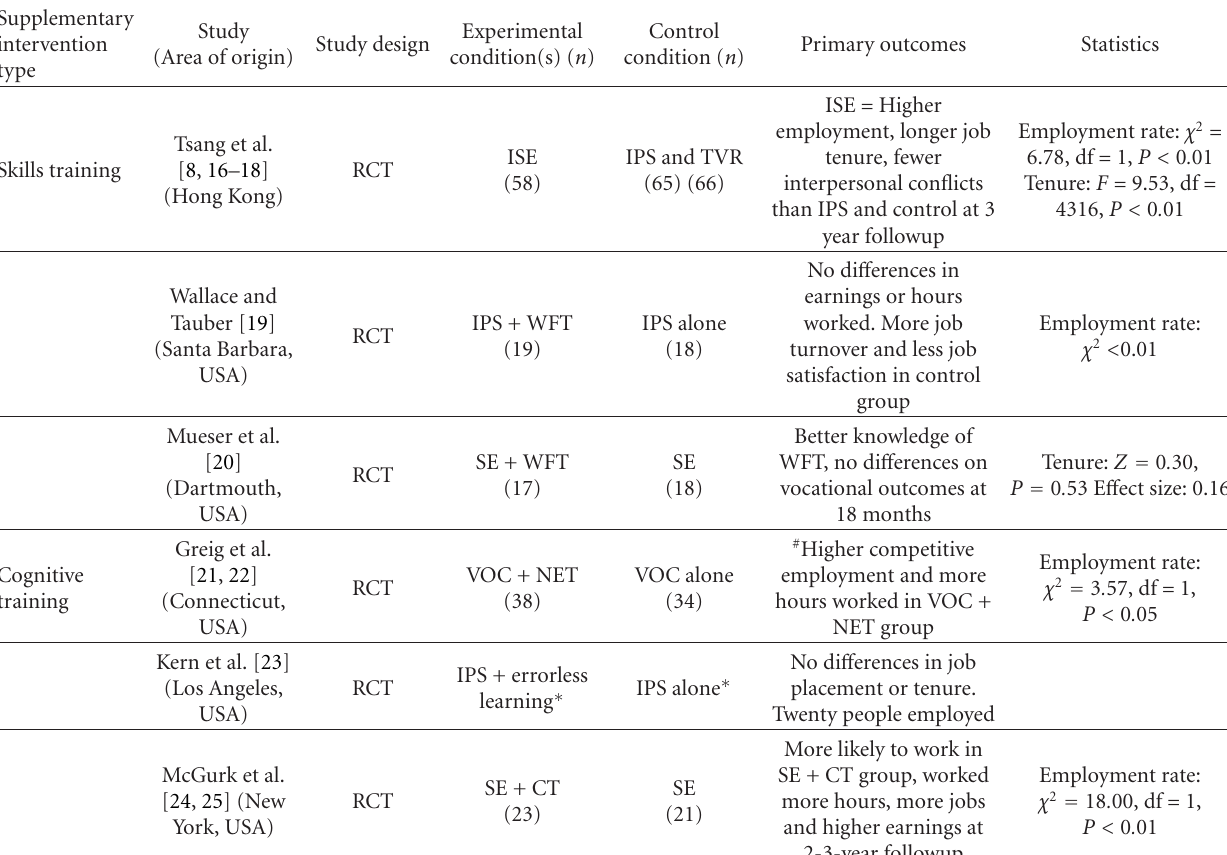
Table 1: Primary outcomes of included